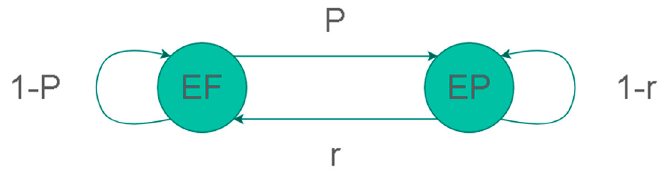
Figure 6. Gilbert–Eliot channel model.